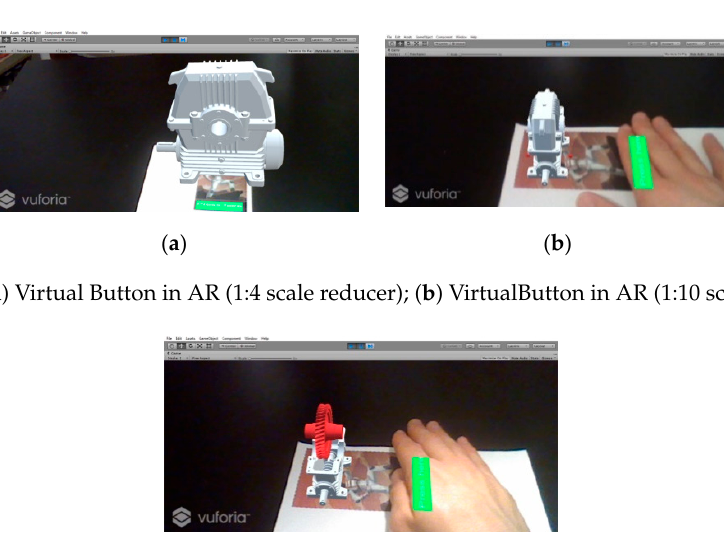
Figure 33. ( a , b ) View of VirtualButton with Unity (scale 1:1).